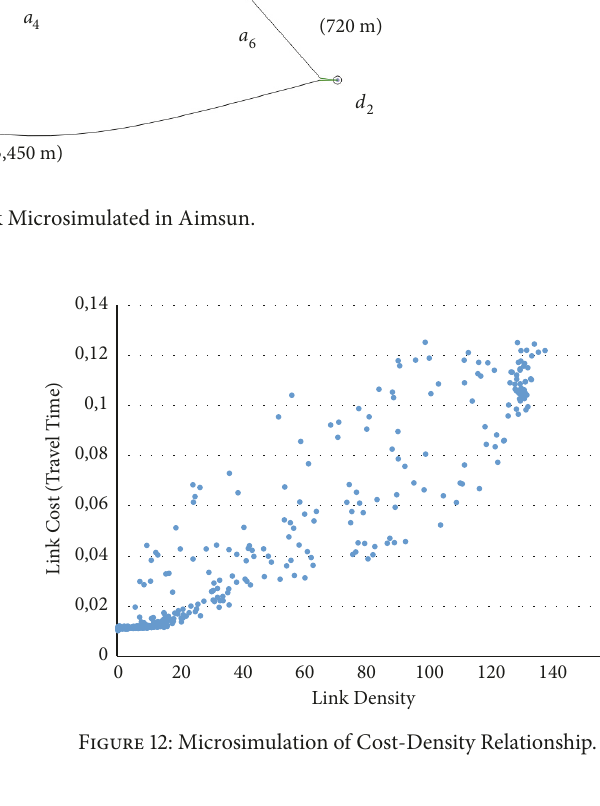
Table 10: O-D Trips and Routes for